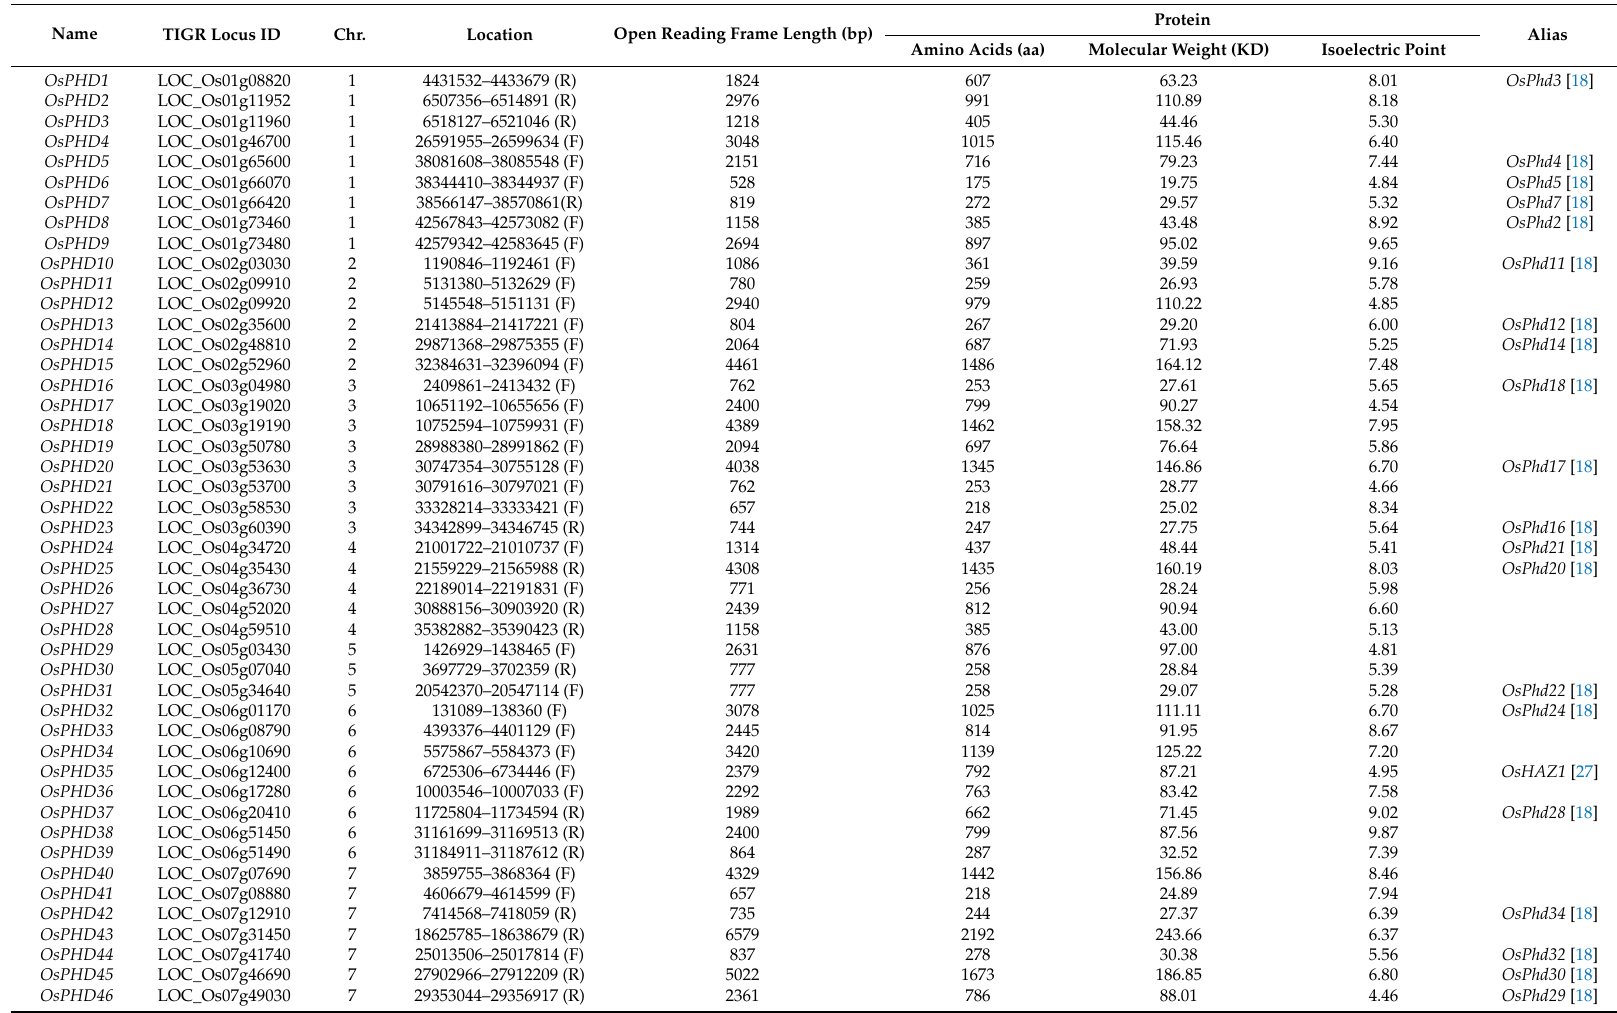
Table 1. Detailed information of all PHD family genes identified in the rice